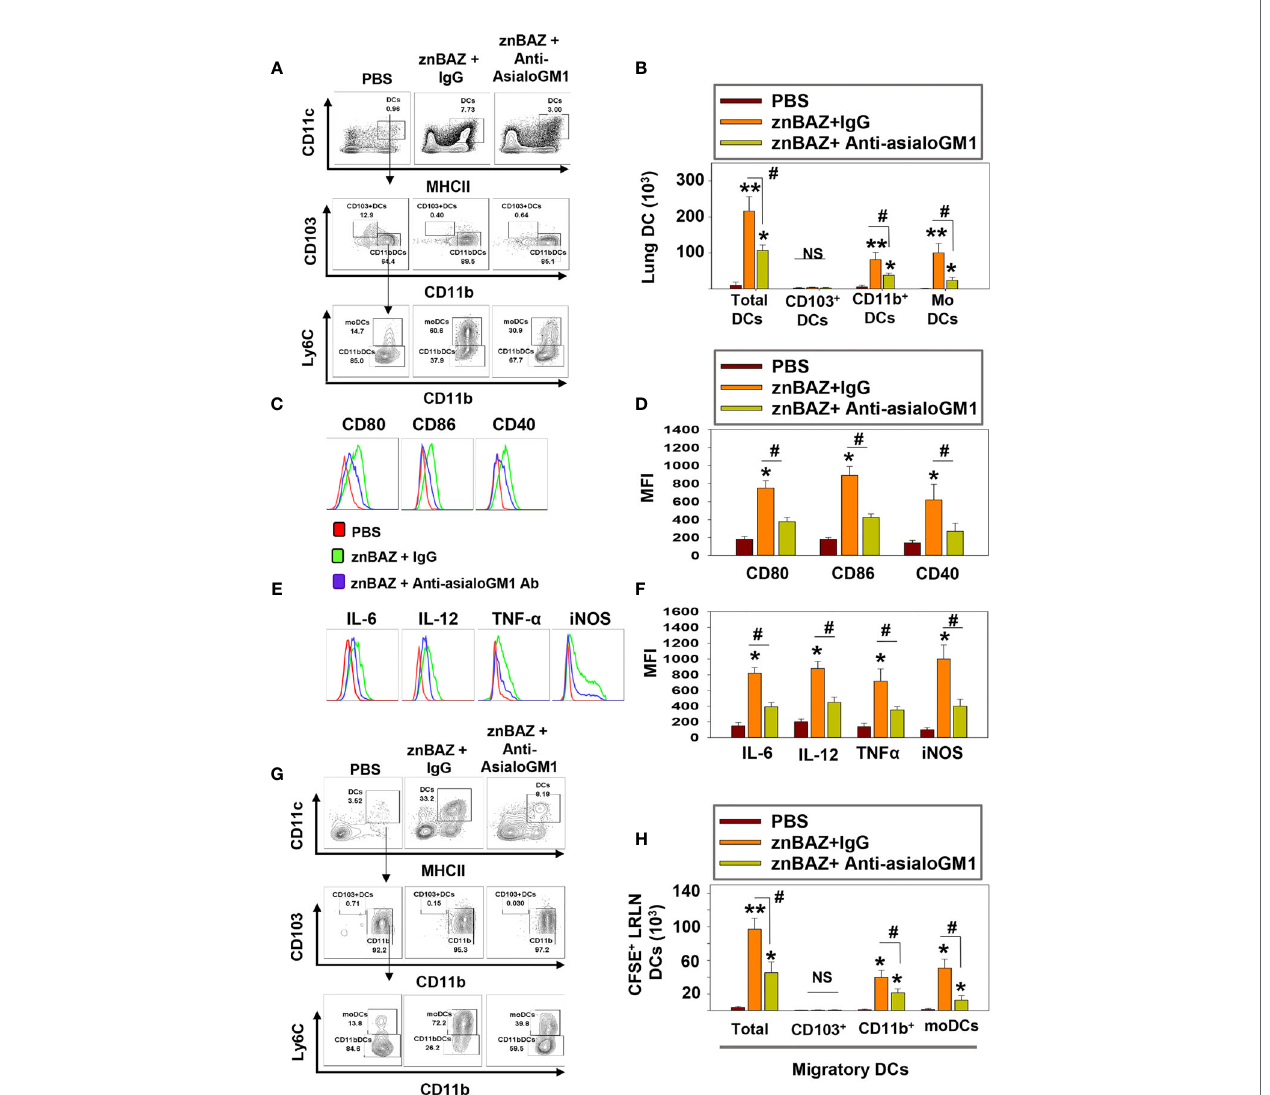
FIGURE 4 | znBAZ induces early NK cell activation, and enhances lung DC maturation and migration to the lower respiratory lymph nodes (LRLNs). (A – H) Groups of BALB/c mice were nasally infected with znBAZ (1×10 9 CFUs) on day 0. One half of znBAZ-infected mice were depleted of NK cells with rabbit anti-asialo-GM1 Ab, and the other half with an equivalent amount of normal rabbit IgG on days -1 and +2. Flow cytometry analysis was performed on day 5 post-infection to determine the (A, B) various DC subset numbers: total MHC class II high CD11c + DCs, CD103 + DCs, CD11b + DCs and monocytic DCs (moDCs); (C, D) their activation status via expression of (C) CD80, CD86, and CD40 expression and (D) respective mean fl uorescence intensity (MFI); and (E) their expression and (F) MFIs for IL-6, IL-12, TNF- a , and iNOS. (G, H) Anti-asialo-GM1 Ab treatment was performed as described above, and mouse lung mononuclear cells were labeled in vivo with CFSE 6 hrs before nasal znBAZ infection. On day 5 post-infection, fl ow cytometry analysis of migratory CFSE + lung DCs in LRLNs was performed on individual mice from the three treatment groups, and the (H) speci fi c numbers are shown. The data depict are the means ± SEM of 5 mice/group; *p < 0.01 and **p ≤ 0.001, # p < 0.01, compared with sPBS-dosed mice or as indicated; NS, not signi fi cant. Data are representative of two or three